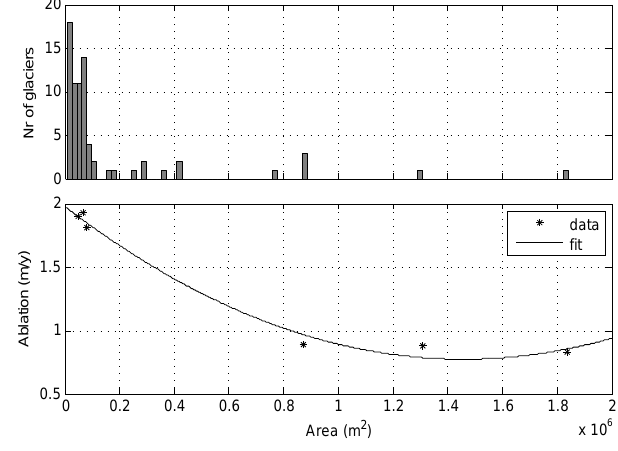
Fig. 5. (a) Glacier area distribution; (b) Ablation-area relationship (mw.e.yr − 1